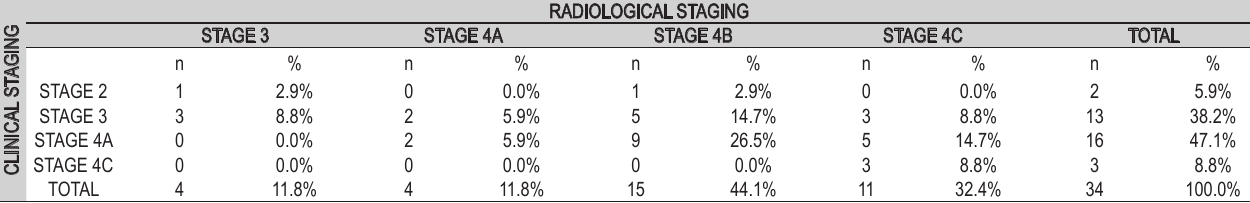
Table 4 - Relationship between the final clinical and radiological staging of HNCs.